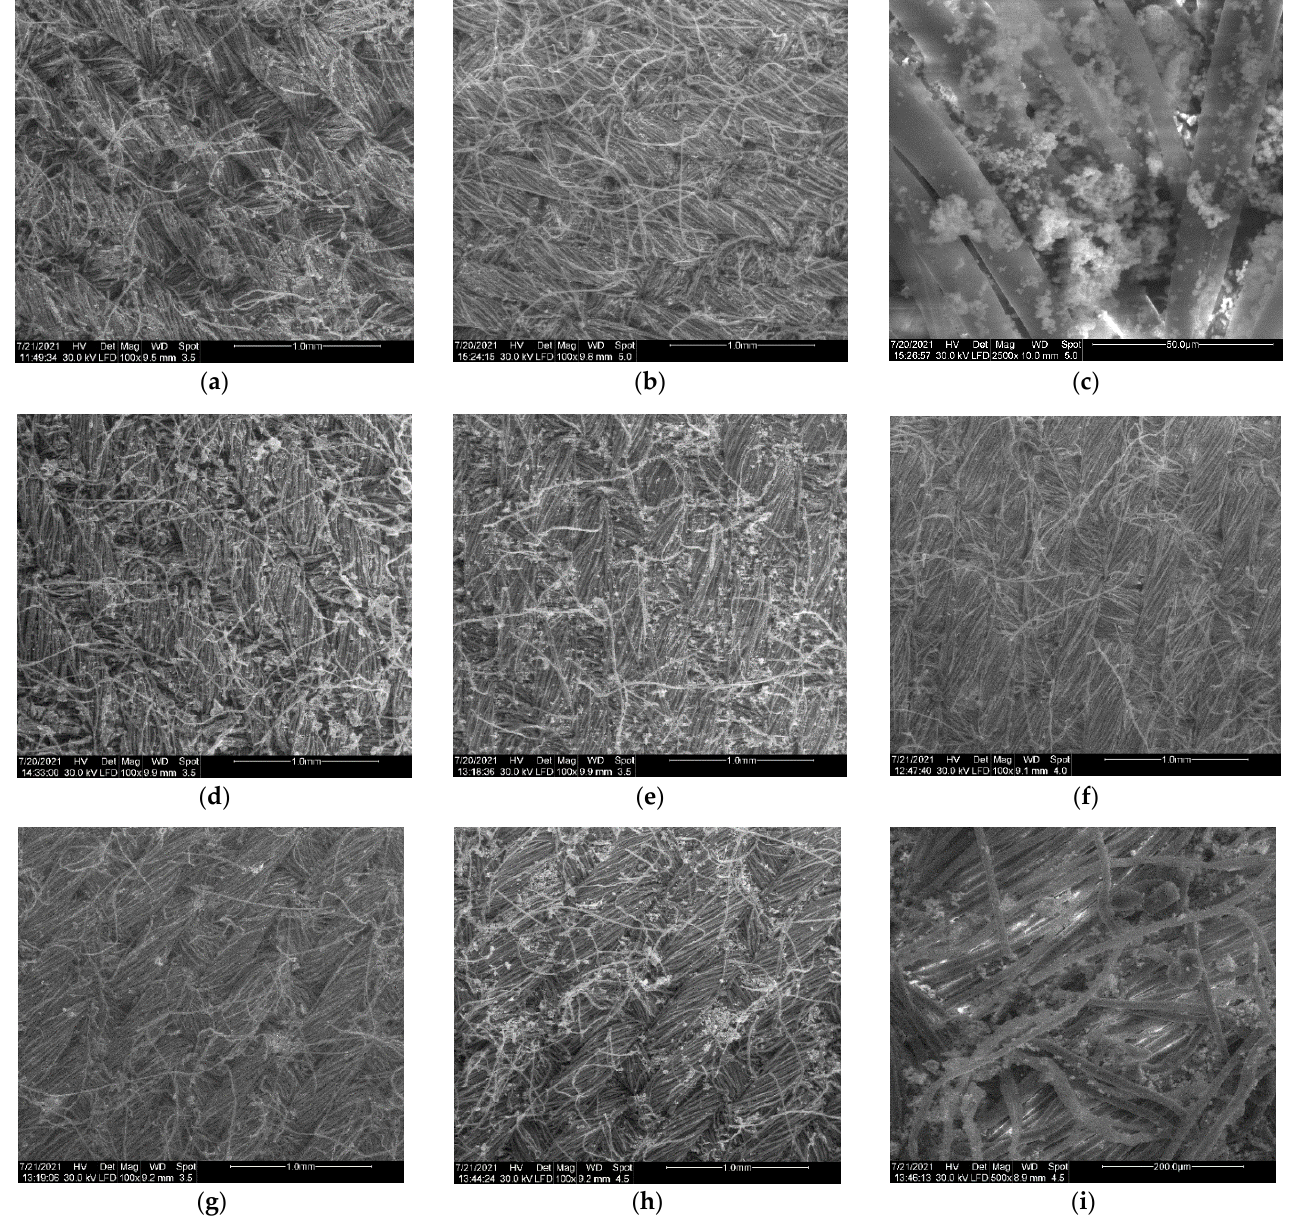
Figure 7. Surface morphology of cotton samples of coated with in situ synthesized ZnO NPs produced by the microwave-assisted method, under various conditions (*). ( a ) ZnO_Am1T; ( b ) ZnO_Am2T; ( c ) ZnO_Am2T high magnification; ( d ) ZnO_Am3T; ( e ) ZnO_Am4T; ( f ) ZnO_Arg1T; ( g ) ZnO_Arg2T; ( h ) ZnO_Arg3T; ( i ) ZnO_Arg3T high magnification. (*) Details on ZnO sample composition are summarized in Table 1.